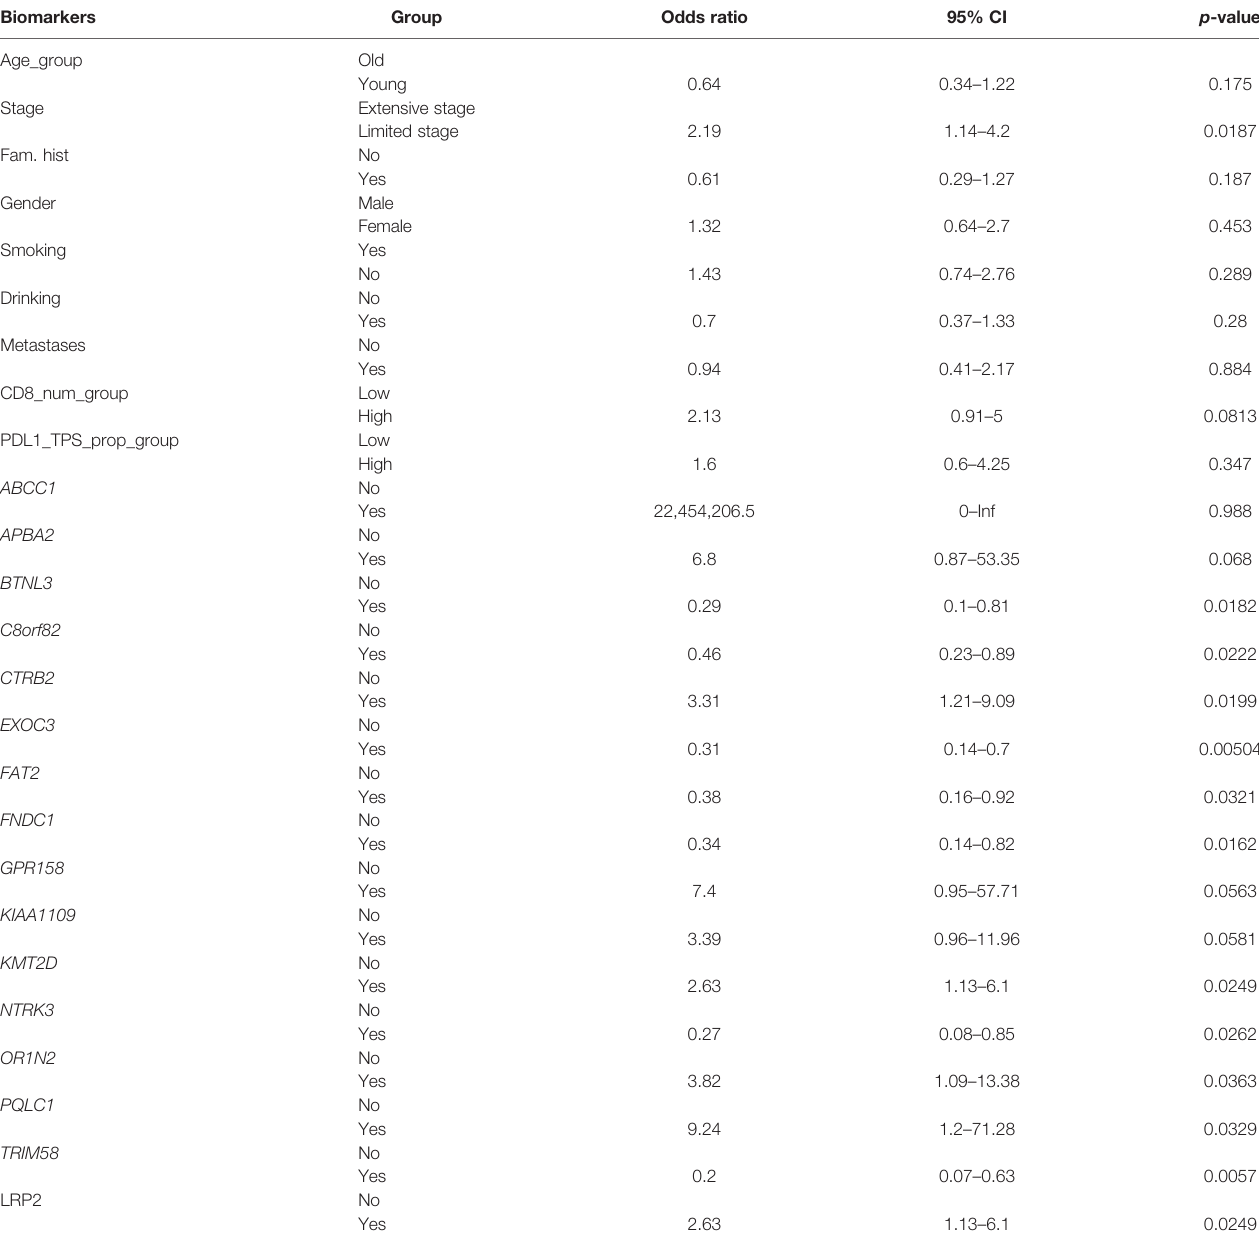
TABLE 1 | Logisic regression models to check the differences in Re and Se groups.